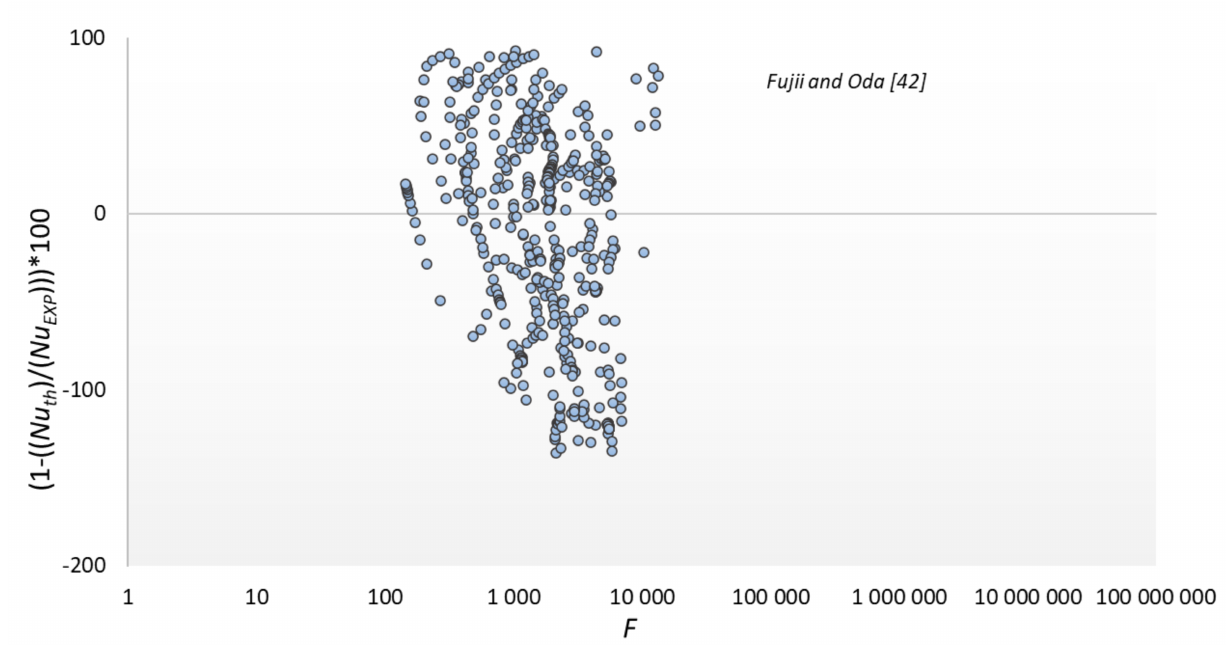
Figure 15. Comparison of experimental data to the model of Fujii and Oda [45].